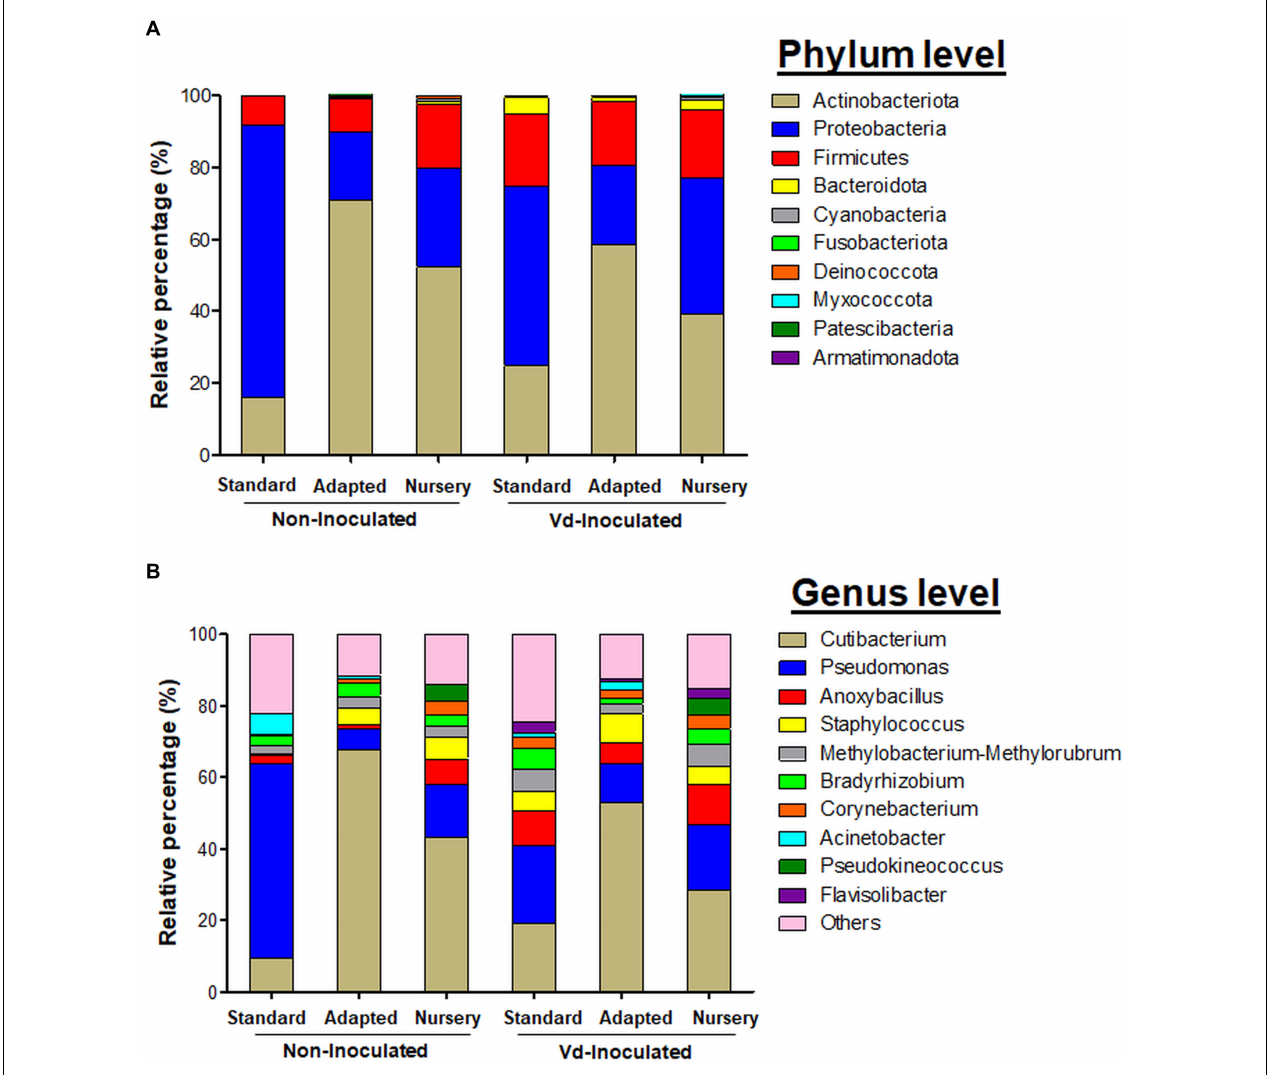
FIGURE 5 | Bar plots showing the relative bacterial abundance taxa at phylum (A) and genera (B) level present in olive xylem from Verticillium dahliae ( Vd )-inoculated and non-inoculated “Ac-18” plants following in vitro (standard and adapted) and nursery propagation